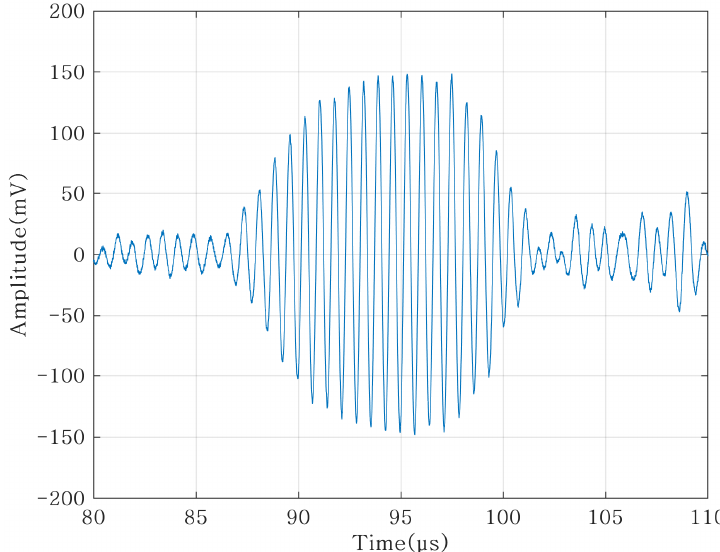
Figure 7. The received signal: time domain waveform.